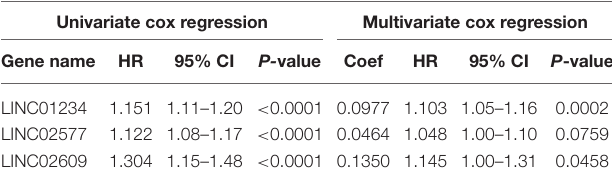
TABLE 3 | Univariate and multivariate cox regression of key